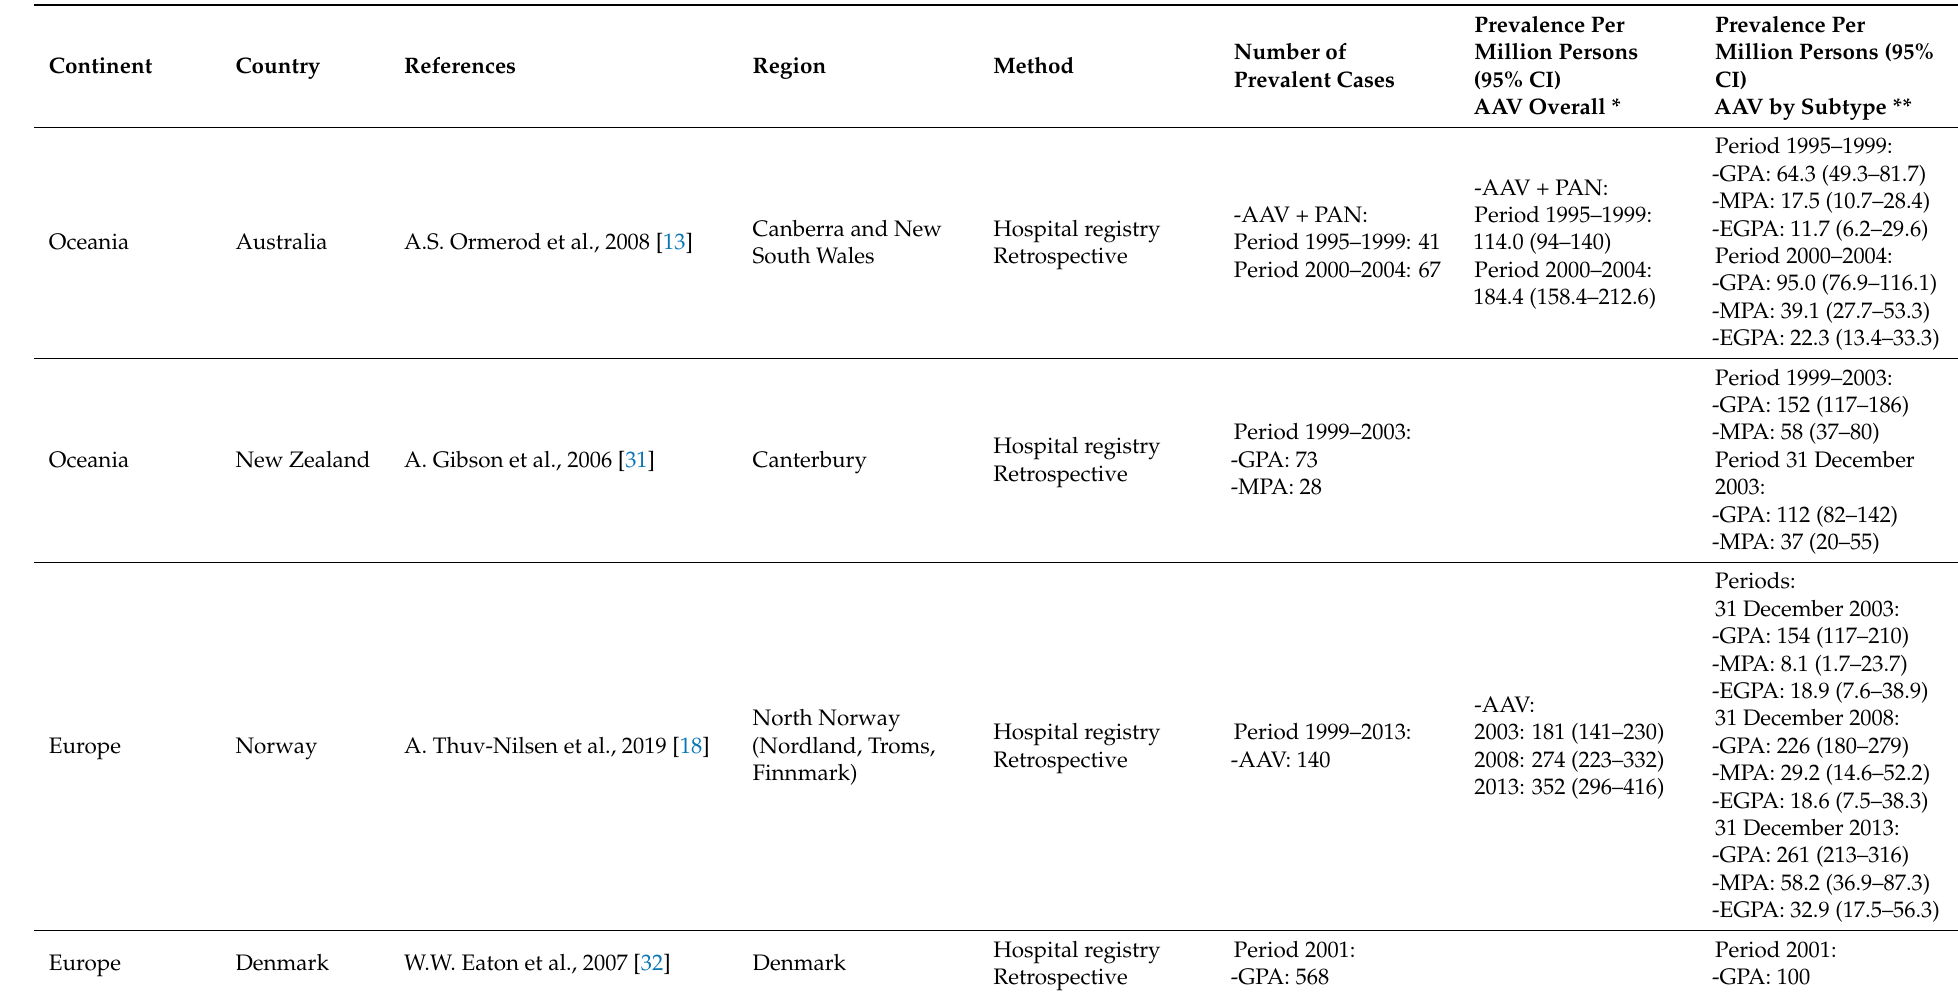
Table 4. Worldwide prevalence of